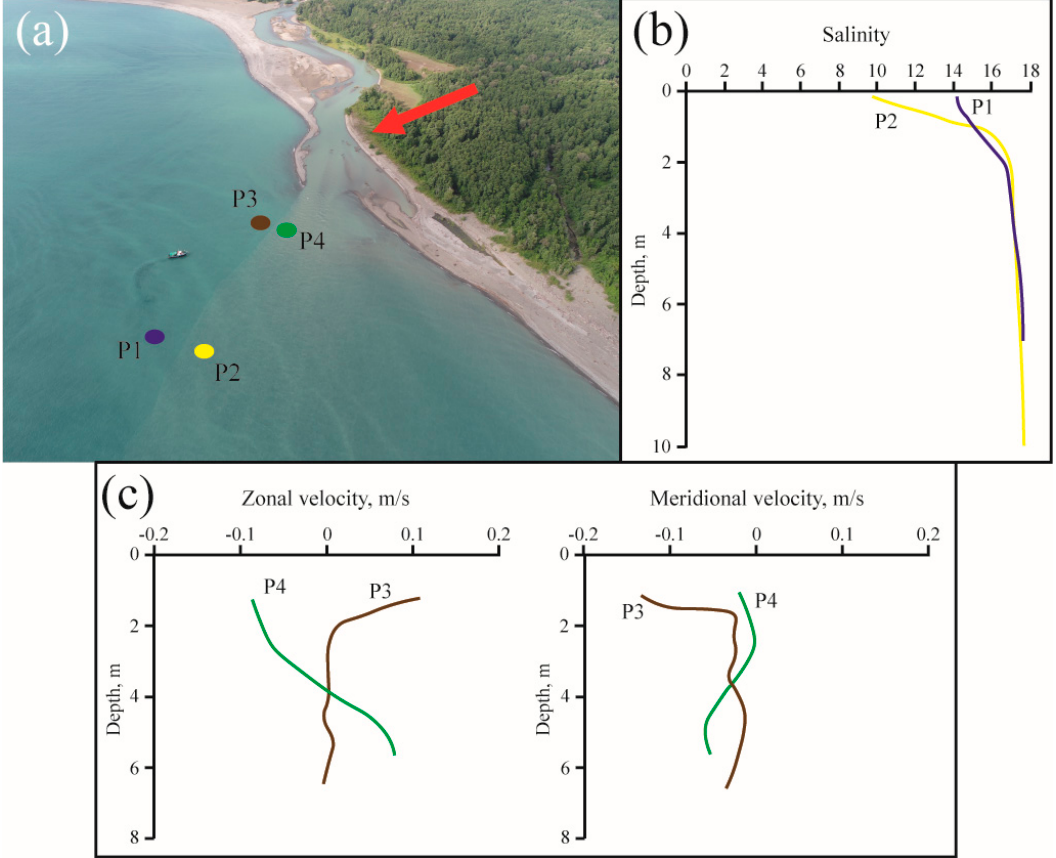
Figure 4. ( a ) aerial image, ( b ) vertical salinity, and ( c ) velocity profiles at the frontal zone between river plumes formed by the northern and central deltaic branches of the Kodor River on 1 September, 2018. Colored dots indicate locations of vertical salinity (P1, blue—the northern plume; P2, yellow—the central plume) and velocity (P3, brown—the northern plume; P4, green—the central plume) measurements. The red arrow in panel (a) indicates location of the central deltaic branch of the Kodor River.